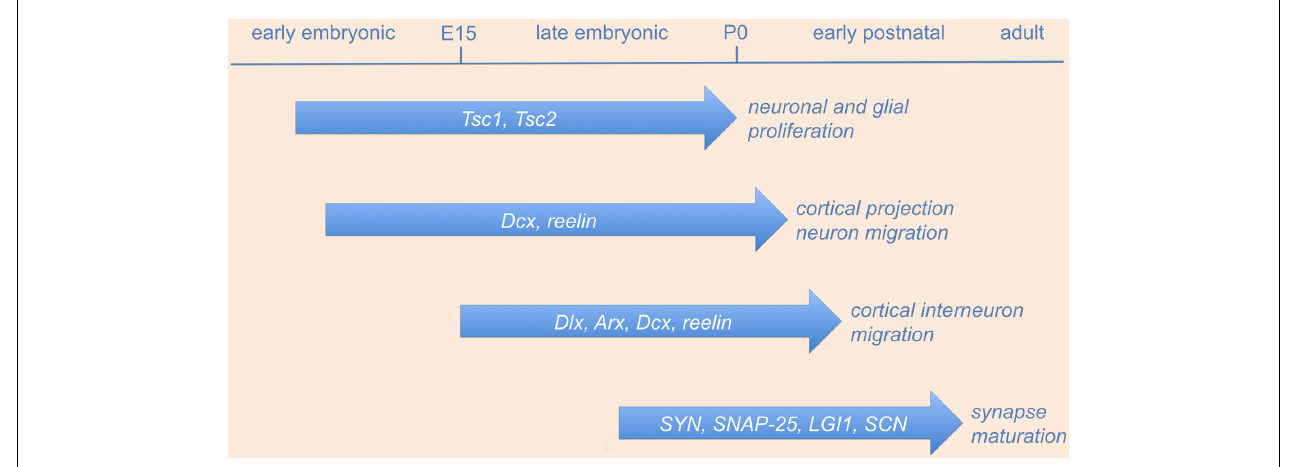
refinement, whose perturbation during embryonic or postnatal development results in epileptogenesis (see text and Table 1 for details). Abbreviations are as in the